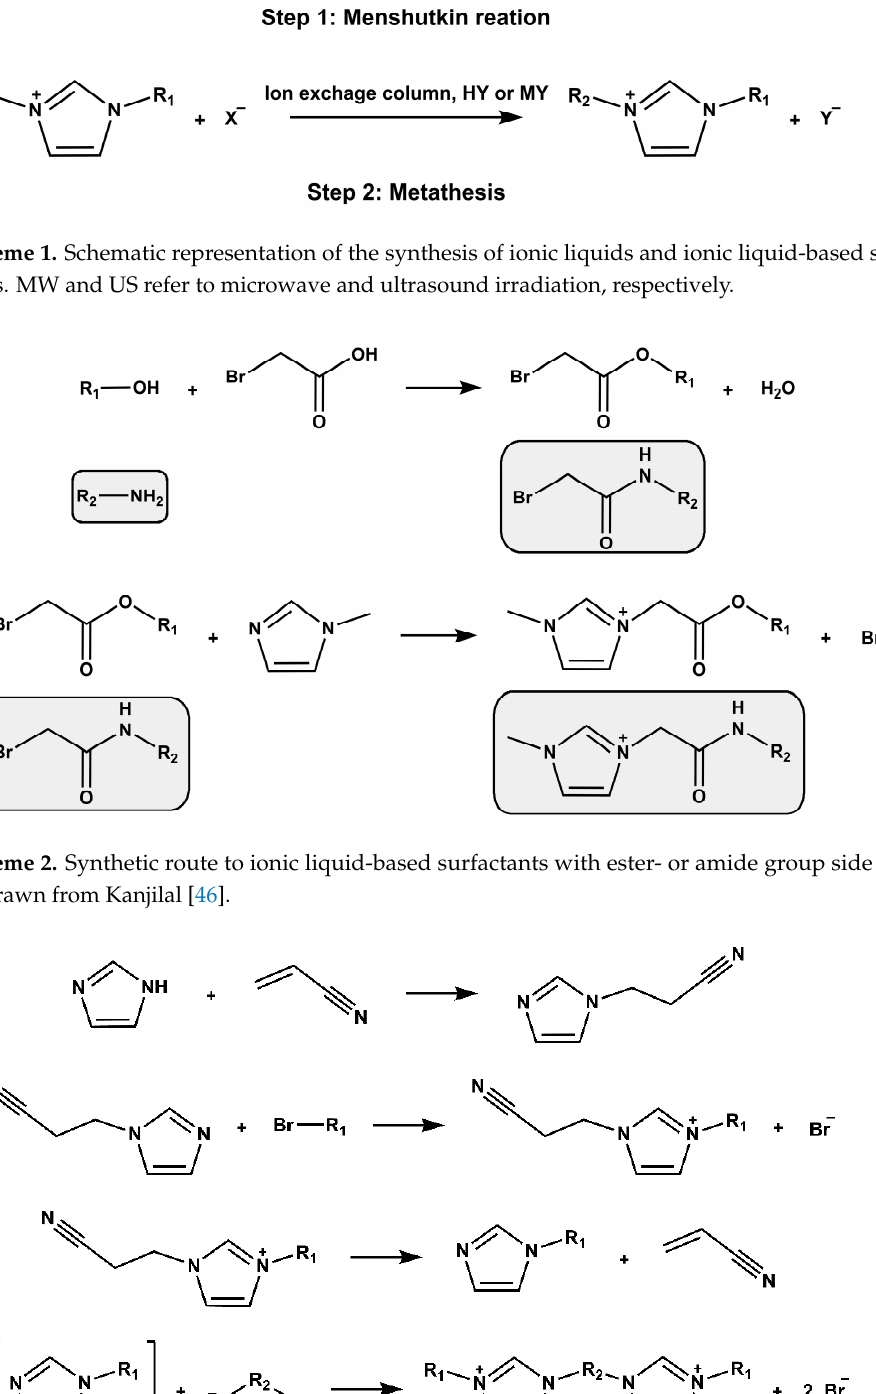
( b ) Figure 2. Number of publications on ionic liquids ( a ) and ionic liquid-based surfactants ( b ) between years 2000–2020, source SciFinder database. 2. Strategies for Synthesizing Mono-Cationic and Gemini Ionic Liquid-Based Surfac- tants The synthesis of ILBS is usually carried out by two consecutive steps: quaternization of amines or phosphines, usually by the S N 2 mechanism (e.g., by the Menshutkin reac- tion) using alkyl halides, or alkyl sulphates, followed by anion exchange, where neces- sary, to yield the desired product. These quaternization reactions are simple and rela- tively efficient. The amine (or phosphine) is mixed with the desired alkyl halide, followed by stirring and heating. The effects of reaction variables on the yield are those known for S N 2 reactions. For example, for alkyl halides, the expected order is RI > RBr > RCl (R = n-alkyl group); an increase in the chain length of R decreases the reaction rate [39,40]. The most frequently employed procedures for the Menshutkin reaction include re- flux in an appropriate molecular solvent, e.g., acetonitrile. The reaction between 1-methylimidazole and 1-chloroalkanes in acetonitrile under reflux generally requires 2